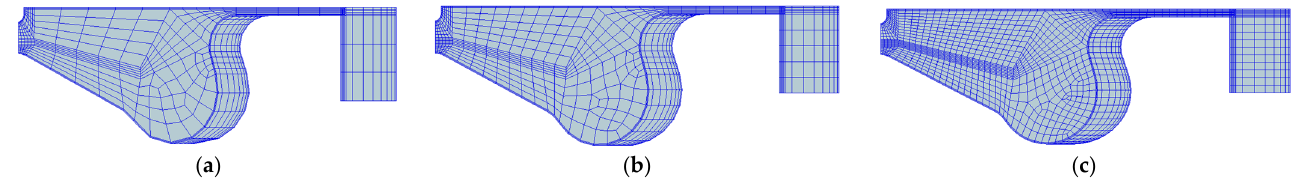
Figure 3. Three calculation girds: ( a ) coarse girds, ( b ) medium girds, and ( c ) fine girds.